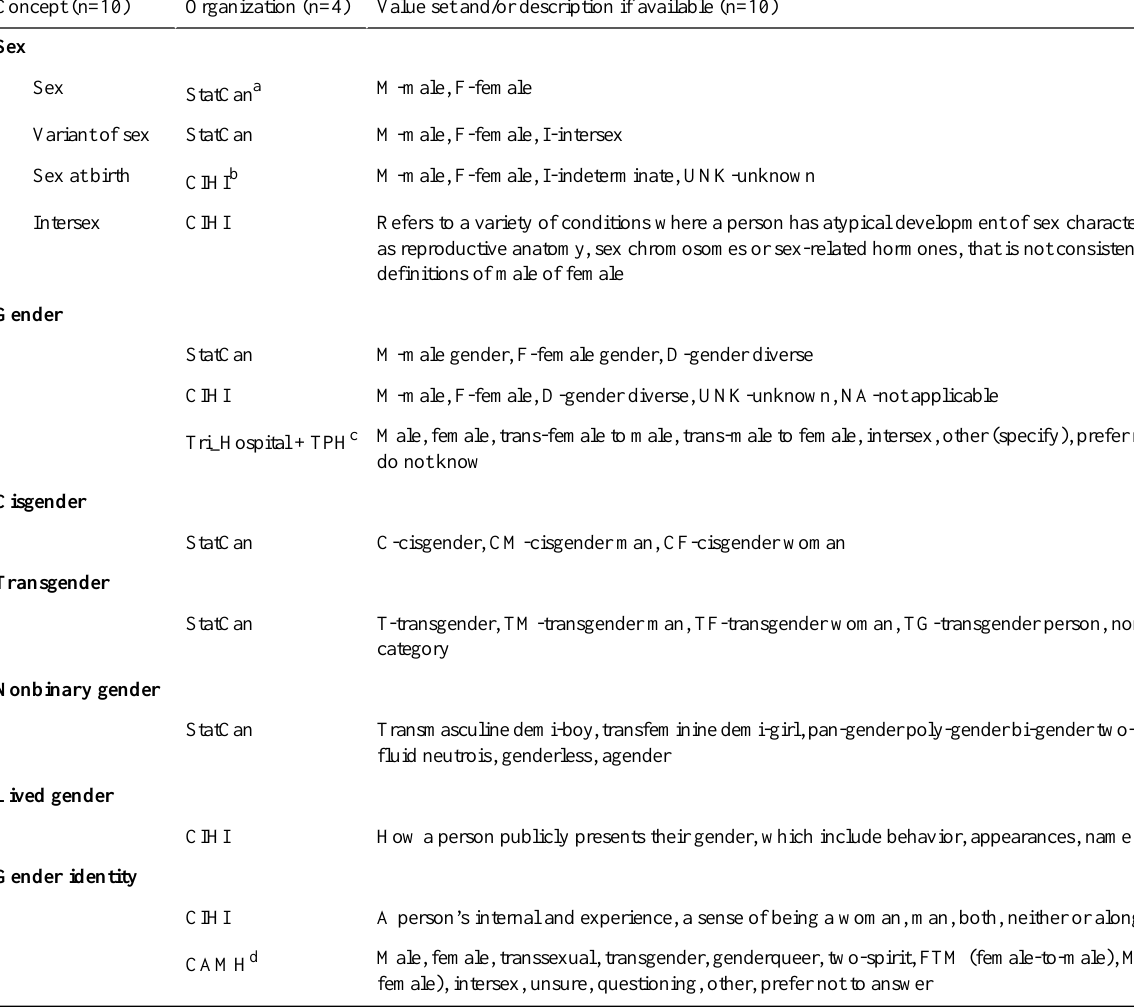
Table 1. Expanded sex and gender definitions in Canadian health care